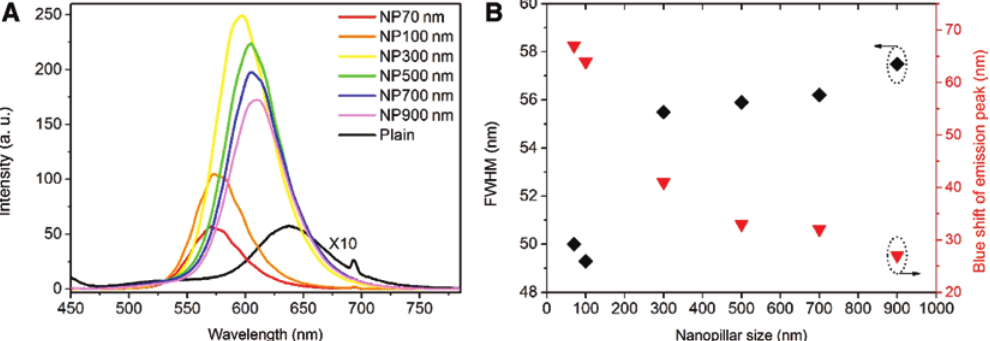
Figure 2: (A) PL spectra of different nanopillar samples and plain reference sample. The spectra are obtained under identical measurement conditions and the surface reflection of excitation laser beam has been taken into account. (B) Emission peak wavelength and FWHM of PL spectra as a function of the nanopillar size.